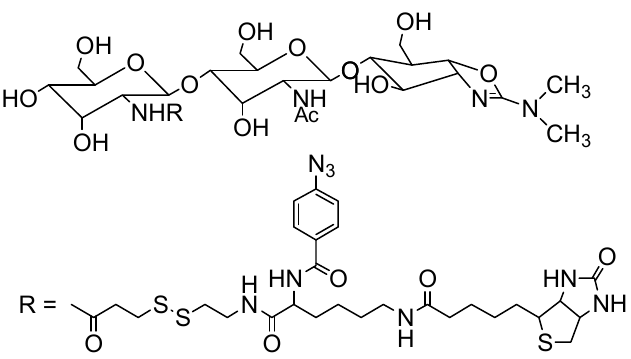
Figure 6. Photoaffinity probe of